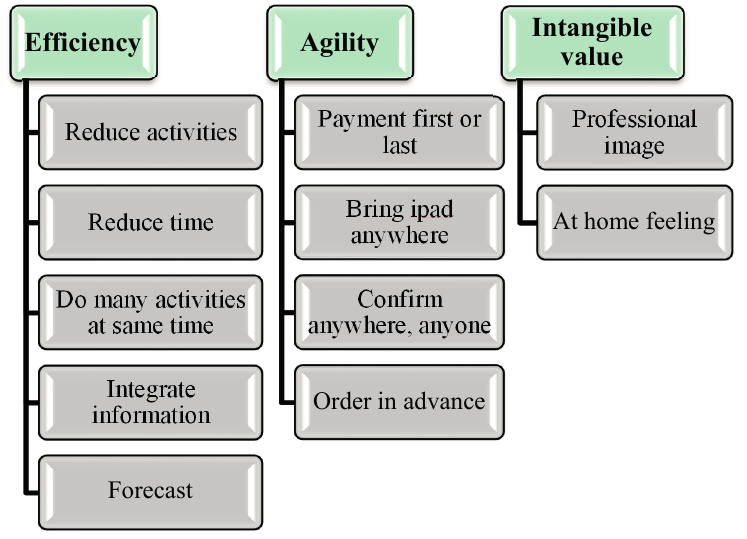
Figure 6. The benefits of iCHEF related to process improvement.